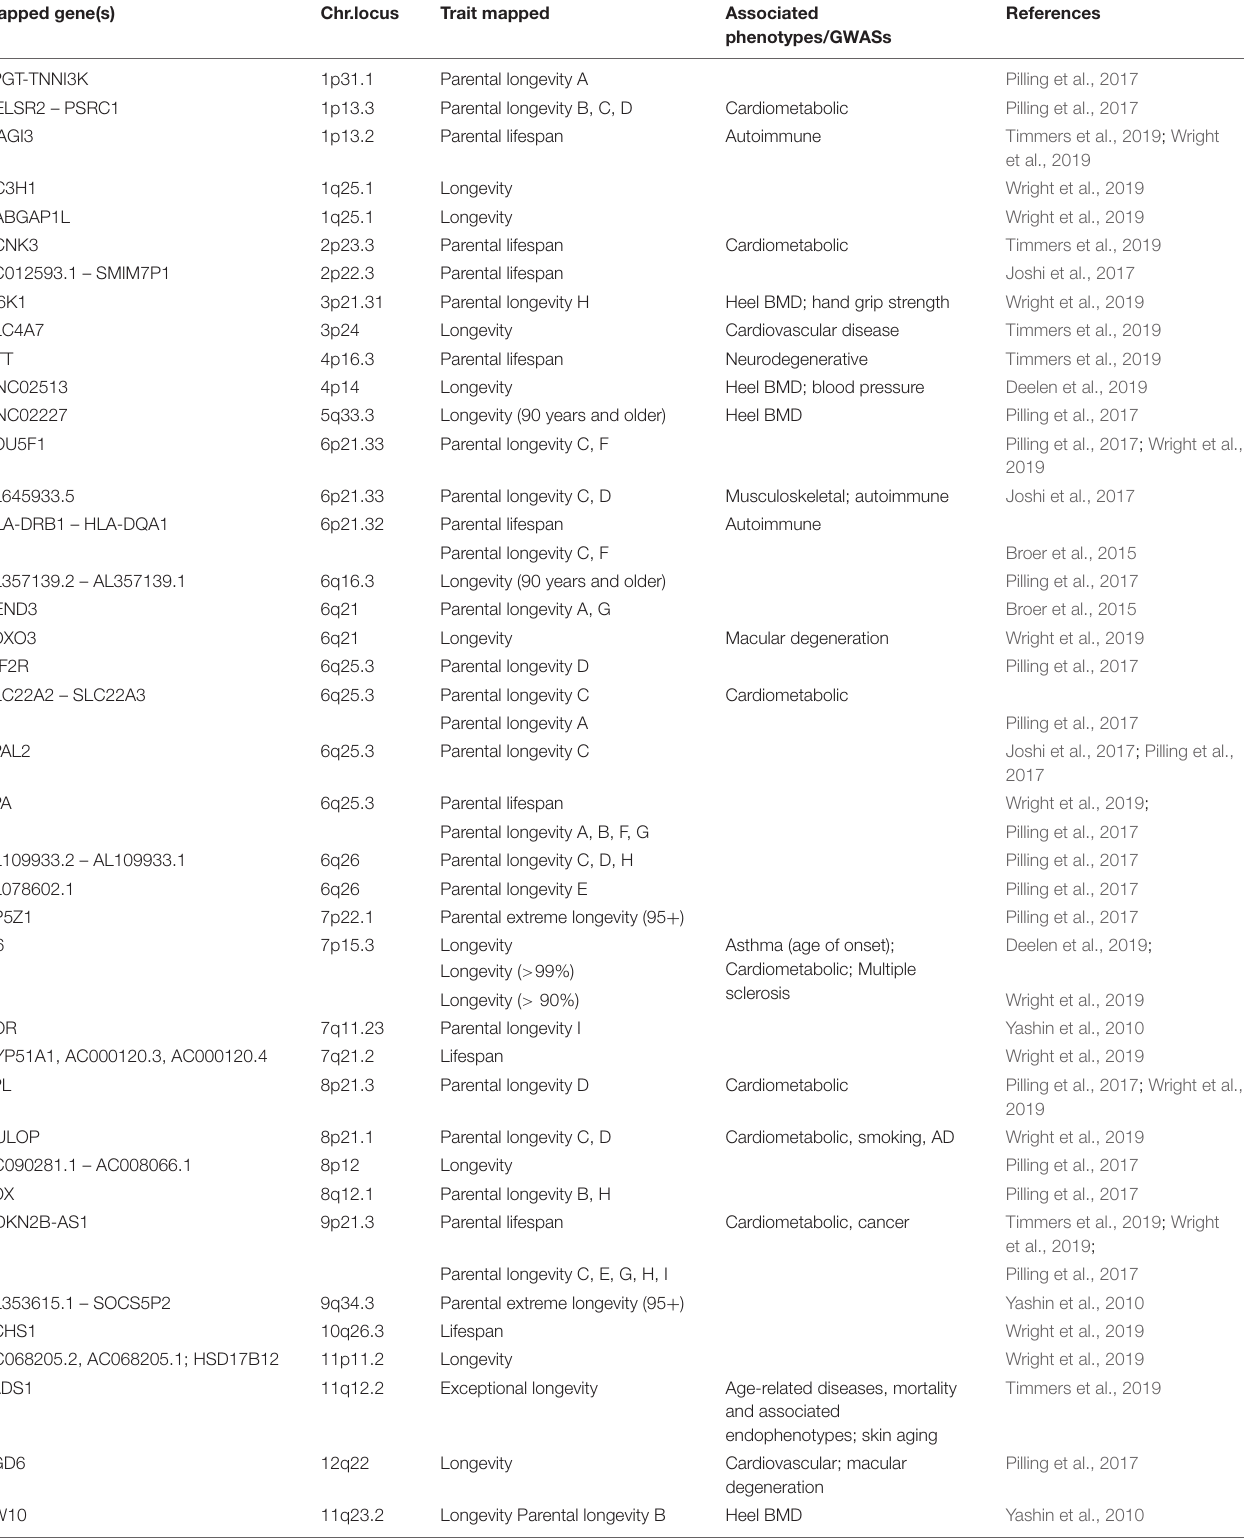
TABLE 1 | Genes/loci identified by genome-wide association studies of longevity and lifespan traits. Mapped gene(s)